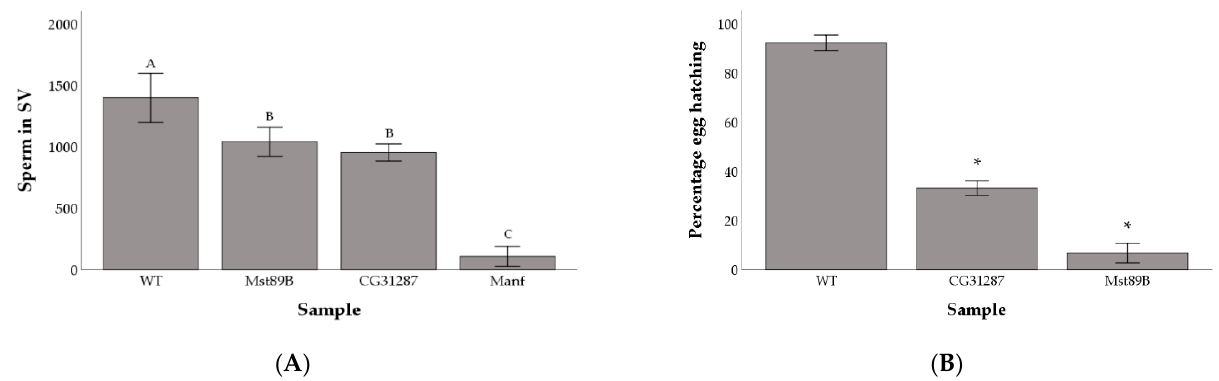
Figure 3. Average number of sperm cells in the male seminal vesicle (SV) ( A ) and percentage of female eggs hatching when mated to control versus gene knockdowns ( B ). Shared letters above bars identify non-significantly different groups. Asterisks (*) above bars denote significant difference between the samples and the wild-type control. Error bars are 2 standard errors of the mean.